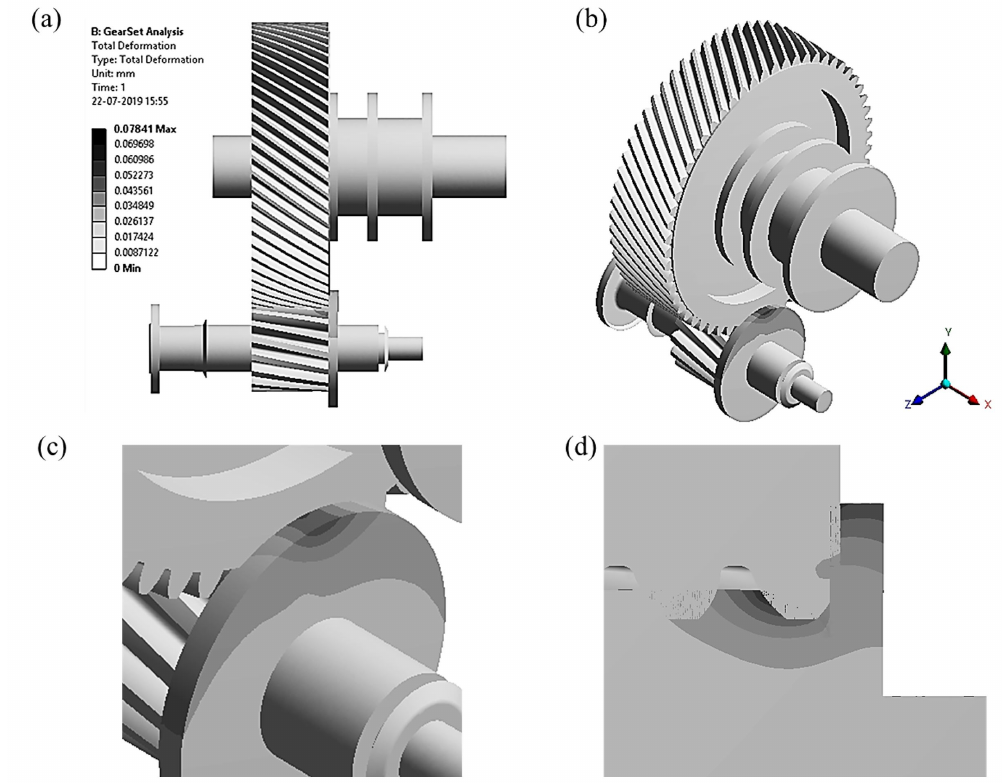
Figure 5. ( a ) Deformation computed using FEA of gearset; ( b ) isometric view of gearset with deformation contours; ( c ) magnified view of deformation contours; ( d ) sectional view of teeth deformation towards thrust